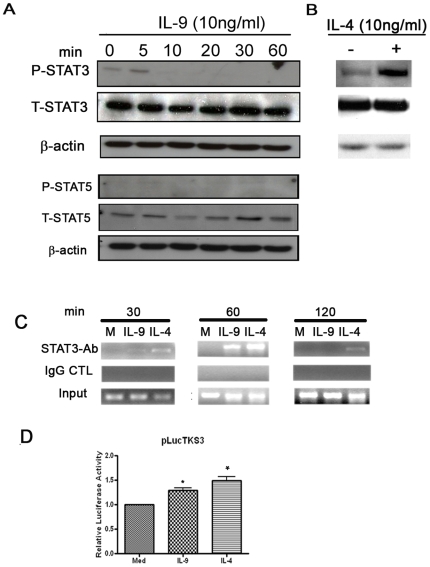
IL-9 induces STAT3 phosphorylation and in vivo binding to CCL11 promoter in ASM cells.A–B. Cells were stimulated with IL-9 (A) or IL-4 (only 20 min is shown in B) and analyzed as described in Figure 1. The data represent one of similar results from 5 independent experiments. C. IL-9 induced STAT3 binding to CCL11 promoter in vivo. Confluent and serum starved human ASM cells were treated with IL-4 (10 ng/ml) or IL-9 (10 ng/ml). The in vivo STAT3 binding to the CCL11 promoter was analyzed by ChIP assay as described under Material and Methods. The input represents PCR products from chromatin pellets prior to immunoprecipitation. The results are representative of three independent experiments with similar results. D. IL-9 driven STAT3 reporter gene activity. STAT3-specific reporter plasmid (pLucTKS3) which harbors seven copies of a sequence corresponding to the STAT3-specific binding site was transfected into ASM cells or with pLucSRE serum response element (SRE) of the c-fos promoter (data not shown) following stimulation by IL-9 or IL-4 as described above. Data in D represent the mean ± SEM from a total of 5 independent experiments.